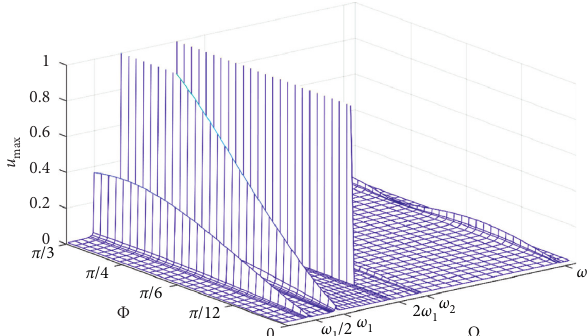
Figure 6: Amplitude-frequency response under different electrode spans.